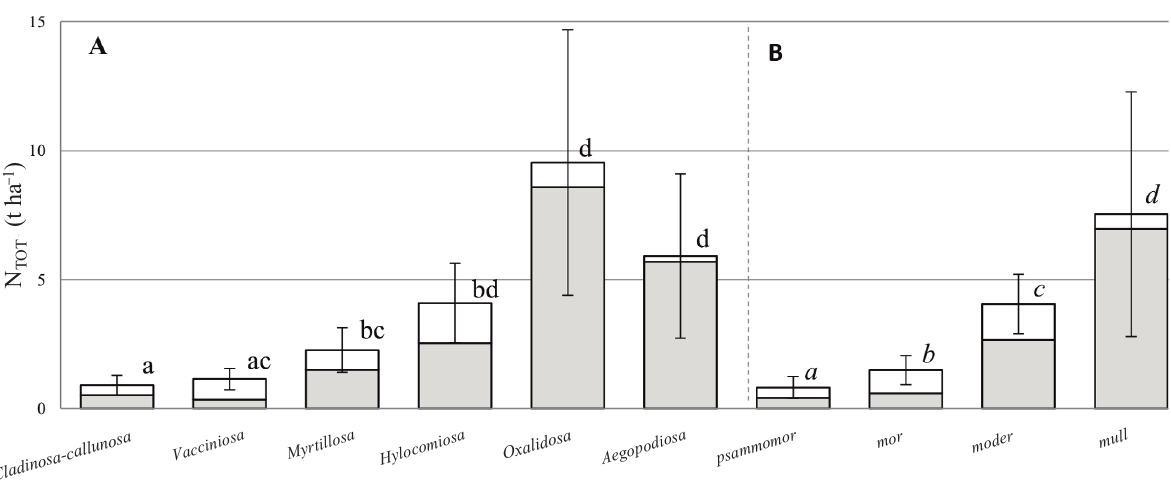
Fig. 3. Mean N stock and distribution in topsoil in different types of forests formed on dry mineral soils ( A ) and humus forms ( B ) TOT in Latvia: in white – the N stock in the O horizon; in grey – the N stock in the A (AE, EA) horizon. Vertical bars show standard TOT TOT deviations of the mean; small letters indicate statistically significant ( p > 0.05) differences between types of forest (regular letters) or humus forms (italic letters) according to Tukey’s